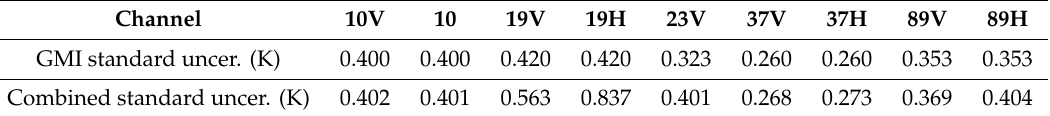
Table 6. Combined uncertainty with GMI calibration